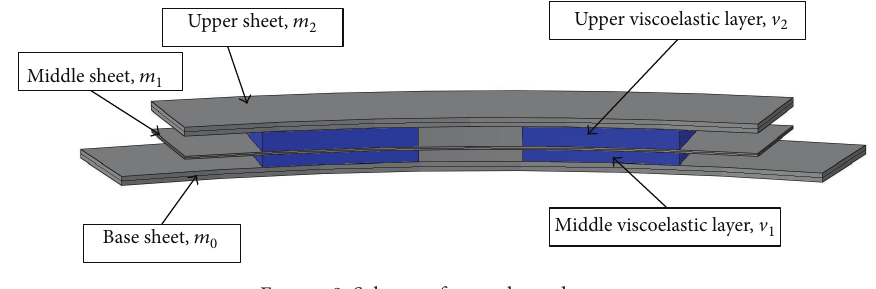
Figure 9: Scheme of a two-layer damper.